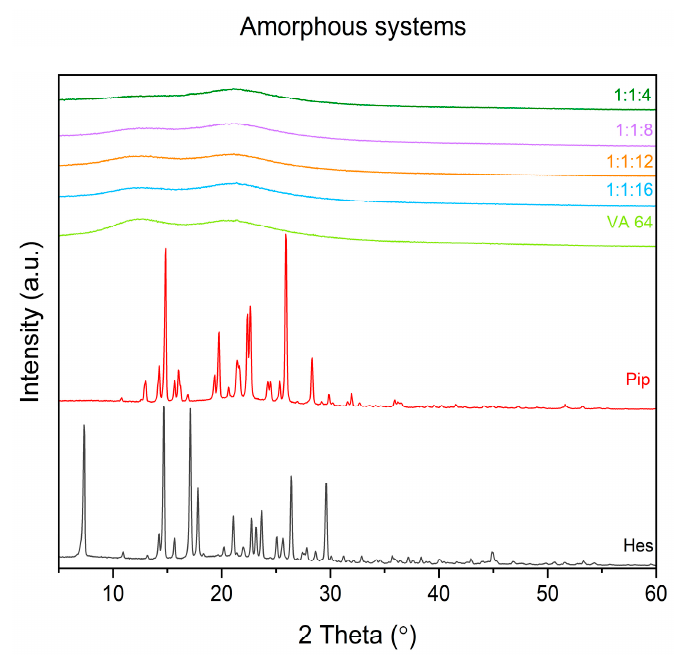
Figure 1. Diffractograms of raw compounds and amorphous systems. Amorphous systems were named as a mass ratio of individual components, Hes:Pip:VA 64 (Hes: hesperetin, Pip: piperine, and VA 64: PVP VA 64).